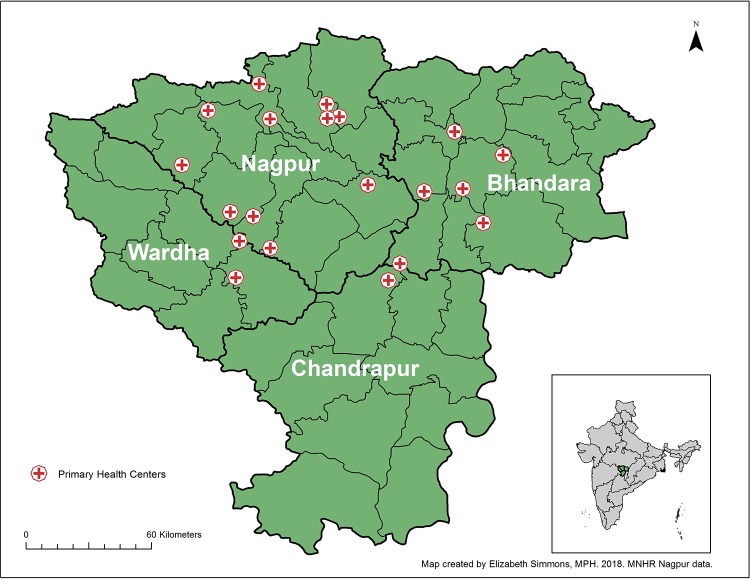
Four districts in Nagpur and locations of primary health centers.